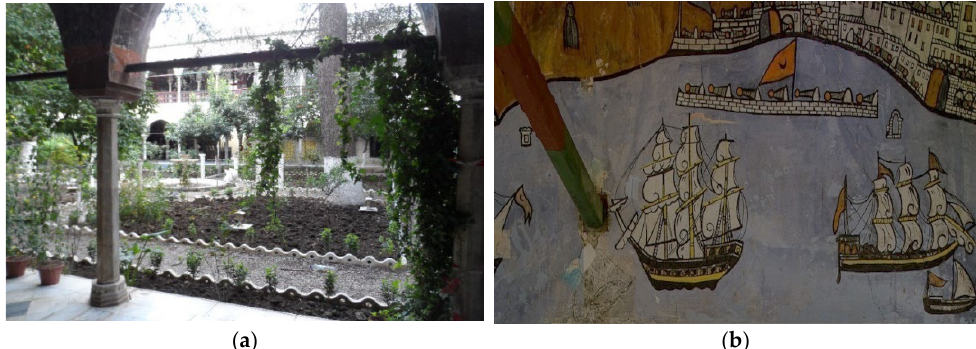
Figure 2. The Haj Ahmed palace: ( a ) the patio of Haj Ahmed palace; ( b ) the image depicting Ahmed’s pilgrimage to Mecca.